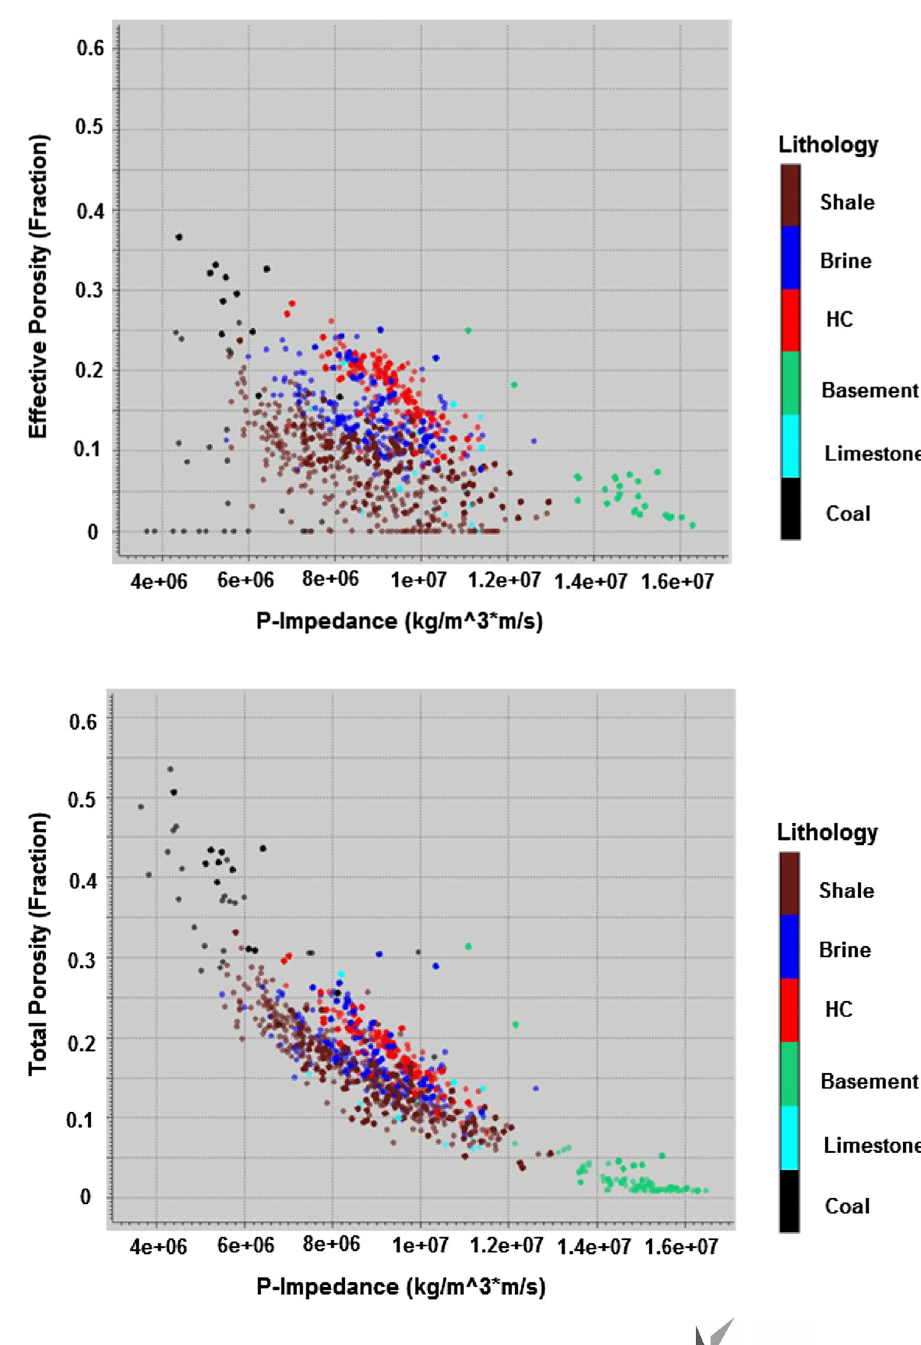
Fig. 21 Measured P-impedance versus total porosity for all the wells colored by